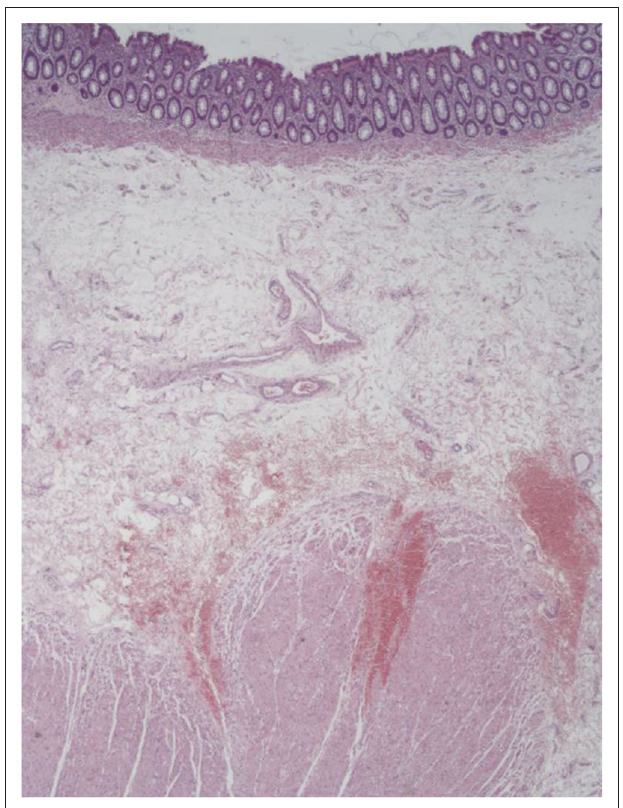
FIGURE 1 | An example of stapled hemorrhoidopexy (SH) specimen: well visible are the mucosa, submucosa, and muscularis propria.